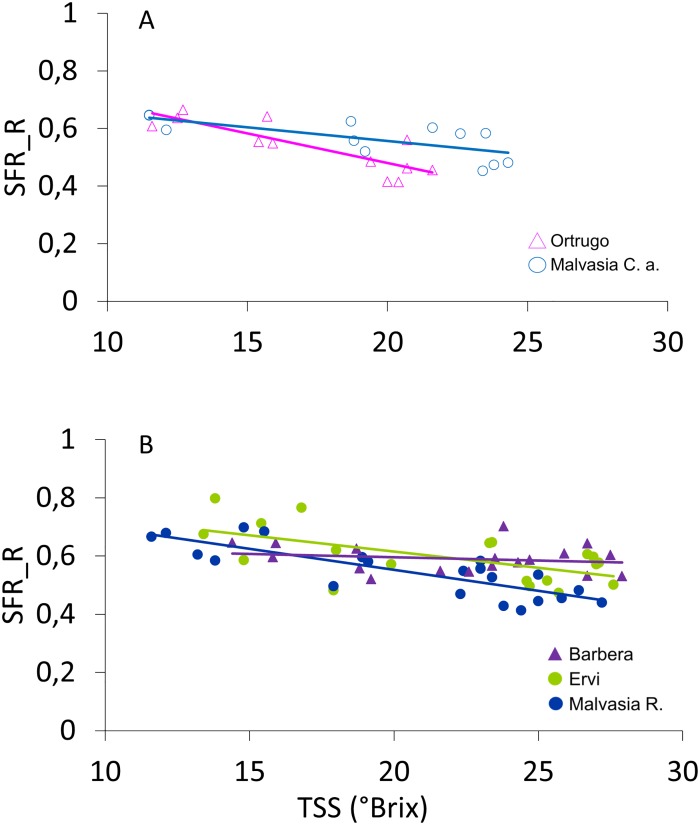
Correlation between field recorded SFR_R index and TSS (°Brix) in the five cultivars grouped as white (A) and colored (B), for TSS values ≥ 10° Brix.In all cases except for Barbera, data were fitted to a significant negative linear model (P < 0.05) having the following equations: y = -0.0205 + 0.8906, R2 = 0.71, n = 12 (Ortrugo): y = -0.0096 + 0.7476, R2 = 0.50, n = 12 (Malvasia C.a.); y = -0-0144x + 0.8405, R2 = 0.68, n = 21 (Malvasia R.); y = -0.063x + 0.7375, R2 = 0.04, n = 21 (Barbera); y = -0.0112x + 0.8398, R2 = 0.37, n = 21 (Ervi).